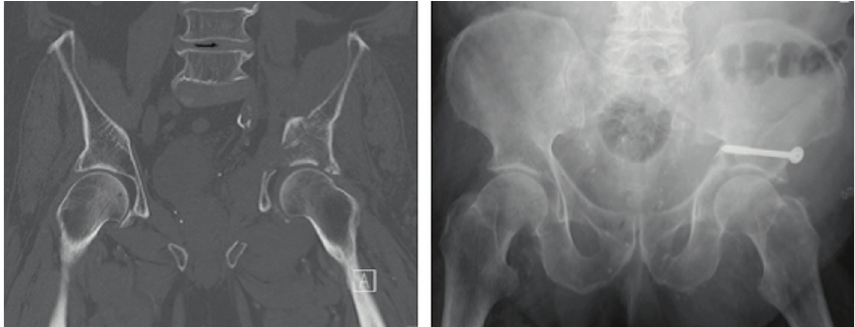
Figure 1. Moribund 81-year-old patient following low energy fall. Besides cardiomyopathy, significant lung fibrosis excluded extensive surgical therapy. The individualized treatment plan was defined as minimal invasive ORIF of the anterior column + posterior hemi-transverse fracture. Minimal invasive surgery was conducted using a cannulated 7.3 mm screw. The postoperative AP view was acquired on the intensive care unit (ICU). No additional follow-up could be conducted, the patient passed away two months following surgery in the rehabilitation